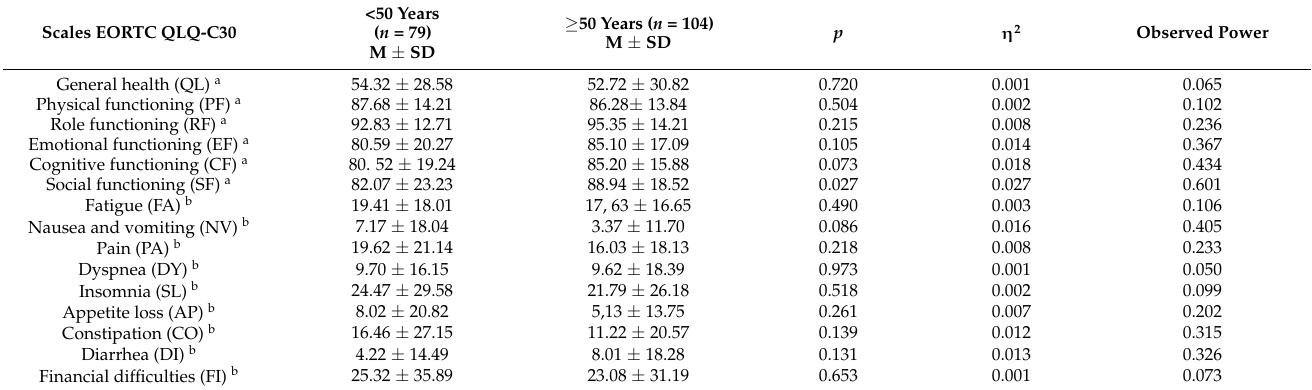
Table 2. Mean score of all items in EORTC QLQ-C30 of the study group (<50 years vs. ≥ 50 years). Scales EORTC QLQ-C30